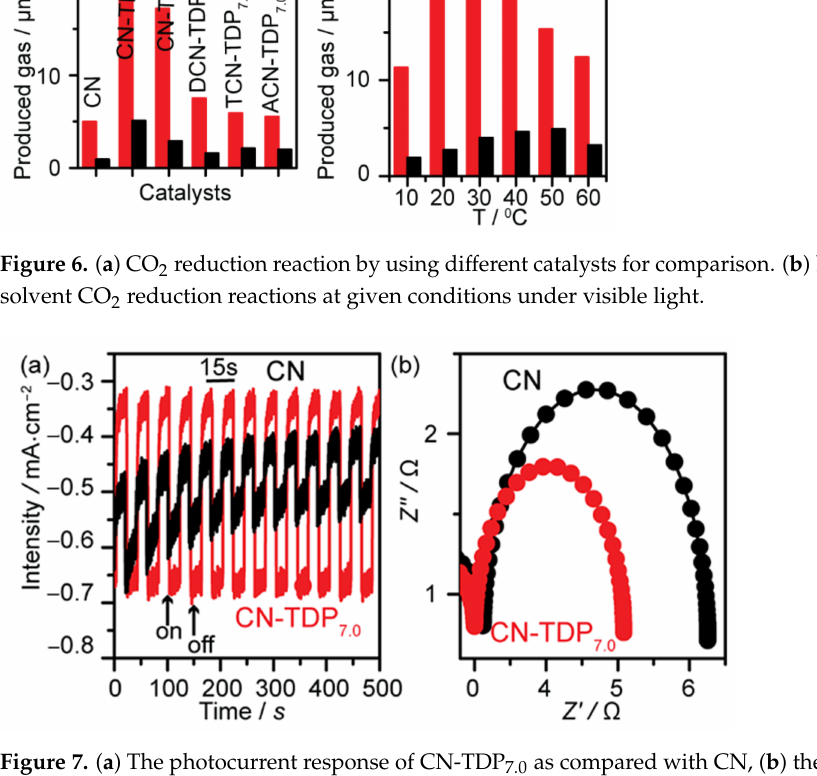
Figure 7. ( a ) The photocurrent response of CN-TDP 7.0 as compared with CN, ( b ) the electrochemical impedance spectroscopy (EIS) Nyquist graph in dark condition for pure CN and modified CN-TDP 7.0